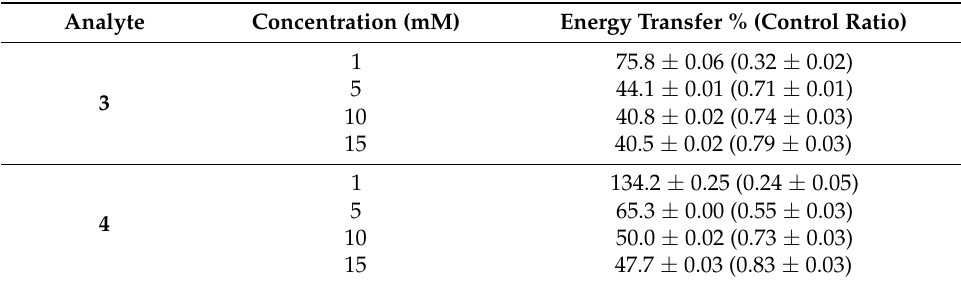
Table 1. Selected energy-transfer results for concentration-dependent energy-transfer experiments with fluorophore 7 as an acceptor. Control ratios are shown in parentheses a . Analyte